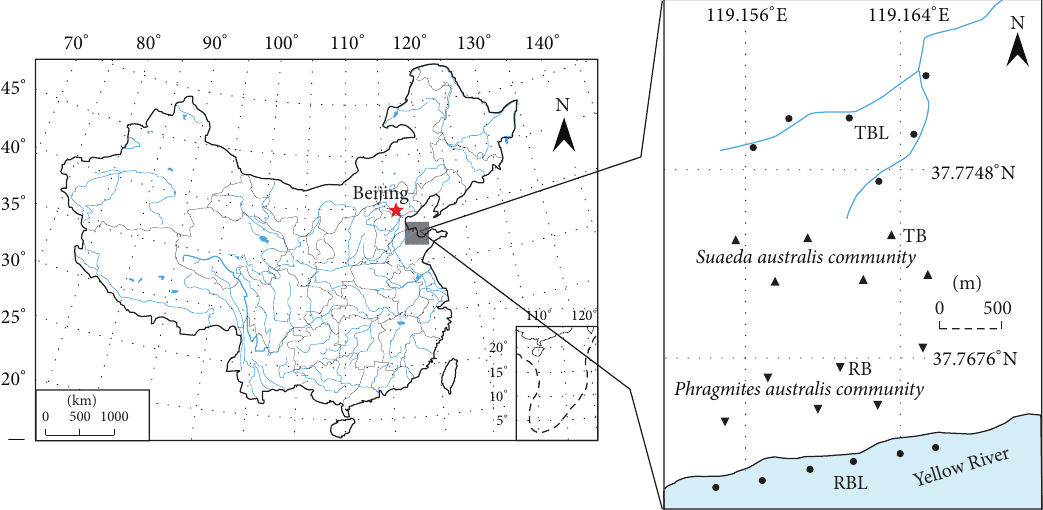
Figure 1: The tidal river network region in the Yellow River Delta estuary and sampling plots in wetlands (including bare river bed (BRB), river bank (RB), tidal bank (TB), and tidal creek bed